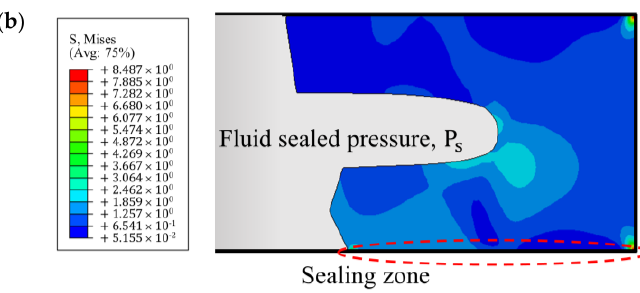
Figure 1. Finite element model: ( a ) seal assembly and ( b ) simulation.